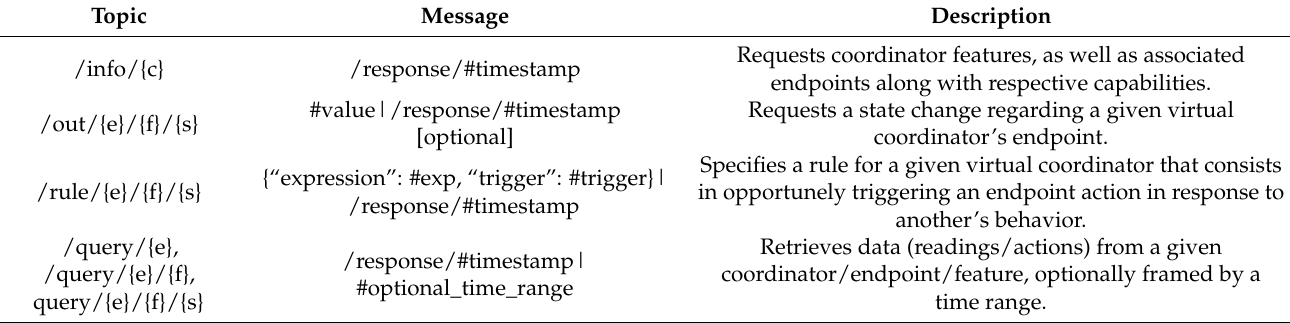
Table 1. IoT server-side publishing topics for communication with subscriptions assigned in the virtual environments side. Different topics/messages are available: “info” topic can be used to retrieve a whole virtual environment; “out” topic requests a state alteration in an endpoint at the virtual environment side; “rule” topic specifies an actuator trig- ger according to a given sensor’ behavior, at the virtual environment side; “query” topic variants can be issued to retrieve sensors’ readings and actuators’ actions, integrally or confined to a time interval. Note that in each case, an expiring subscription topic with a timestamp (/response/#timestamp) is specified in the messages, allowing the coordinator of the targeted virtual environment side to